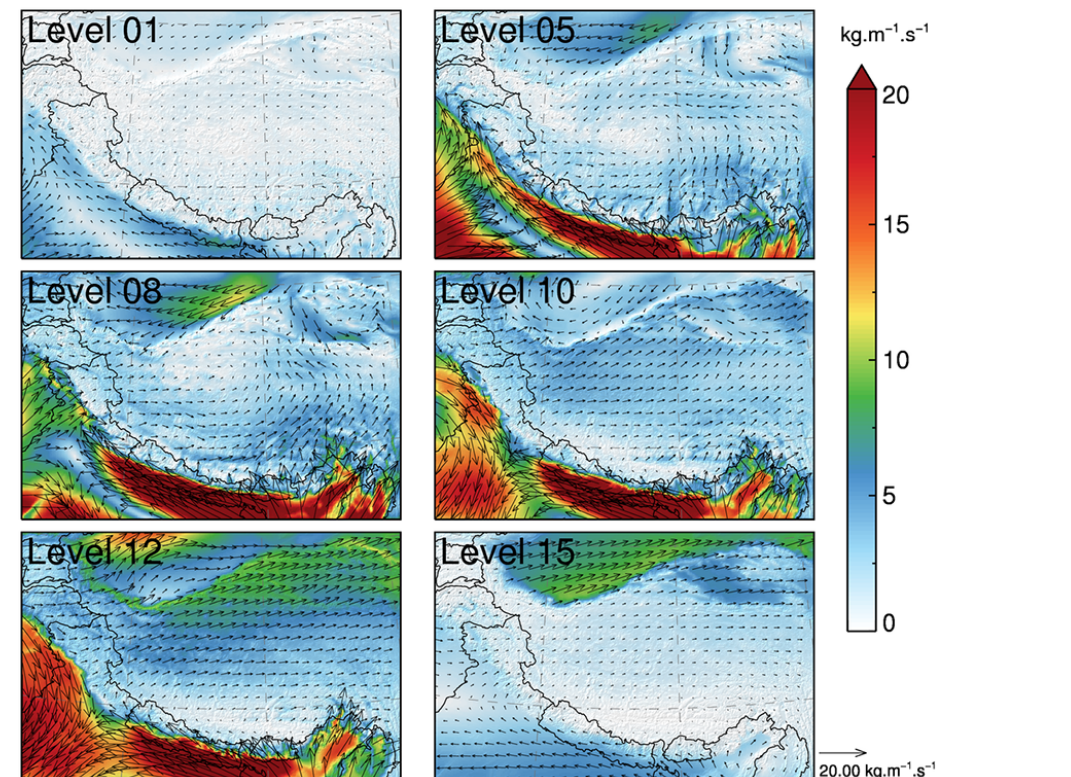
Figure 8. Decadal average of the water vapour flux (kgm − 1 s − 1 ) for single selected model levels (1 ( ∼ 25m above ground in Tibet), 5 ( ∼ 450m above ground in Tibet), 8 ( ∼ 1200m above ground in Tibet), 10 ( ∼ 2200m above ground in Tibet), 12 ( ∼ 3200m above ground in Tibet) and 15 ( ∼ 5500m above ground in Tibet)) in July for HAR10. Colour shading denotes strength of water vapour flux, arrows (plotted every eighth grid point) indicate transport direction (length of arrows is proportional to flux strength up to 20kgm − 1 s − 1 and is constant afterwards for more readability).